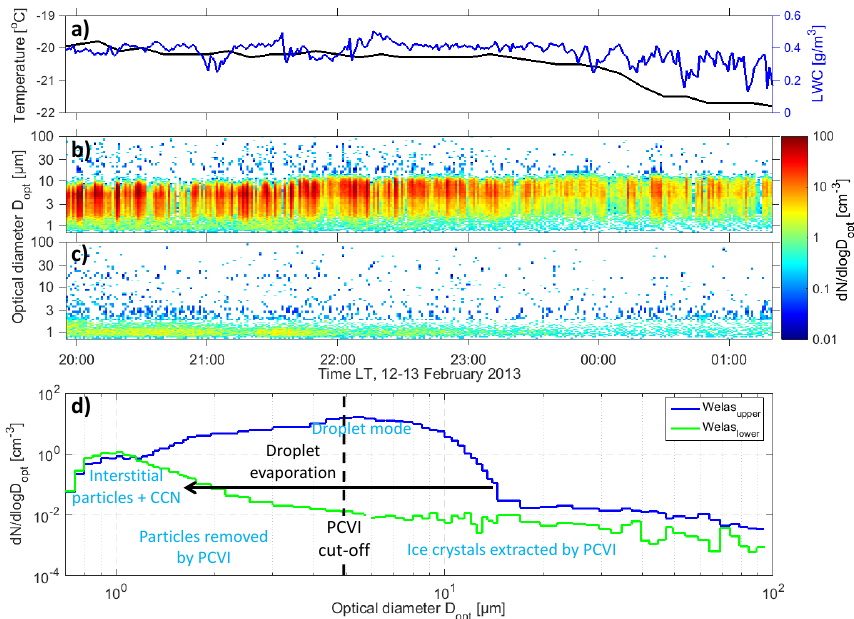
Figure 11. Measurements of liquid water content, air temperature and particle number size distributions during the CLACE 2013 case study period of 19:55LT, 12 February 2013 to 01:20LT, 13 February 2013. Panel (a) shows air temperature (black curve) and liquid water content (blue curve); panels (b) and (c) show time resolved size distributions measured with the upper and lower ISI WELAS 2500 sensors respectively; and panel (d) shows average size distributions for the case study period from the two WELAS sensors with an overlaid description of the processes at work in the ISI, and the resulting size distribution